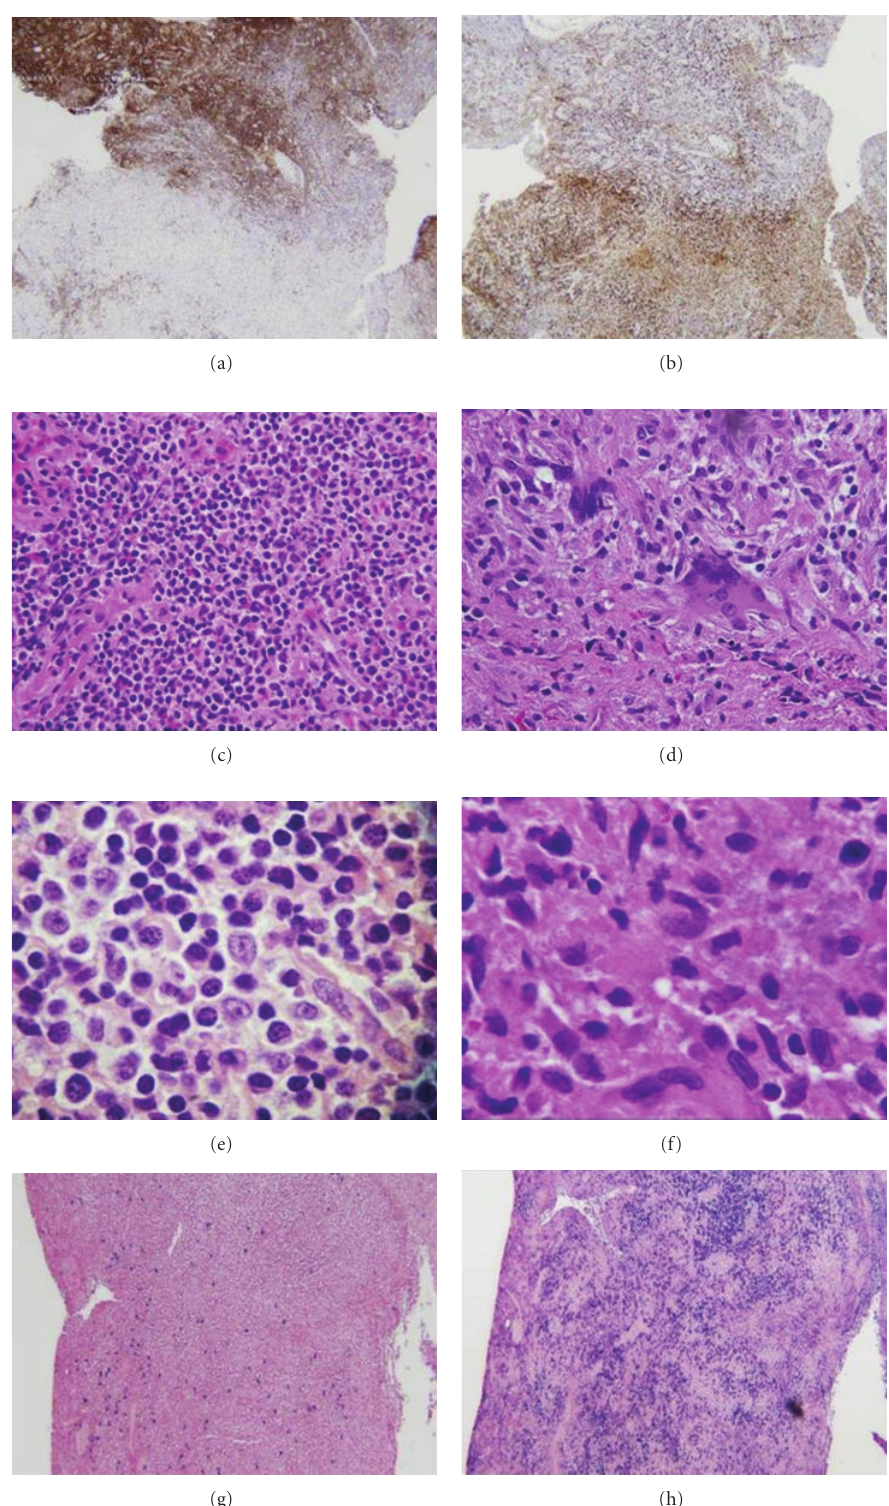
Figure 1: Morphologic features of lymph node. Images are from the antemortem lymph node biopsy. (a and b) CD20 and CD68 immunoperoxidase stains highlight the B-cell-rich and histiocyte-rich regions, the lymph node corresponding to areas involved by marginal zone B-cell lymphoma (a) and Erdheim-Chester disease (b), respectively, 100x magnification. (c and e) lymphoplasmacytic infiltrate present in the B-cell-rich areas, hematoxylin, and eosin, 200x and 400x magnification. (d and f) Histiocytic infiltrate with occasional Touton type giant cells in histiocyte-rich-regions, 200x and 1000x magnification. (g and h) In situ hybridization for kappa (g), and lambda (h), in lymphoplasmacytic areas of lymph node demonstrating lambda predominance, 100x